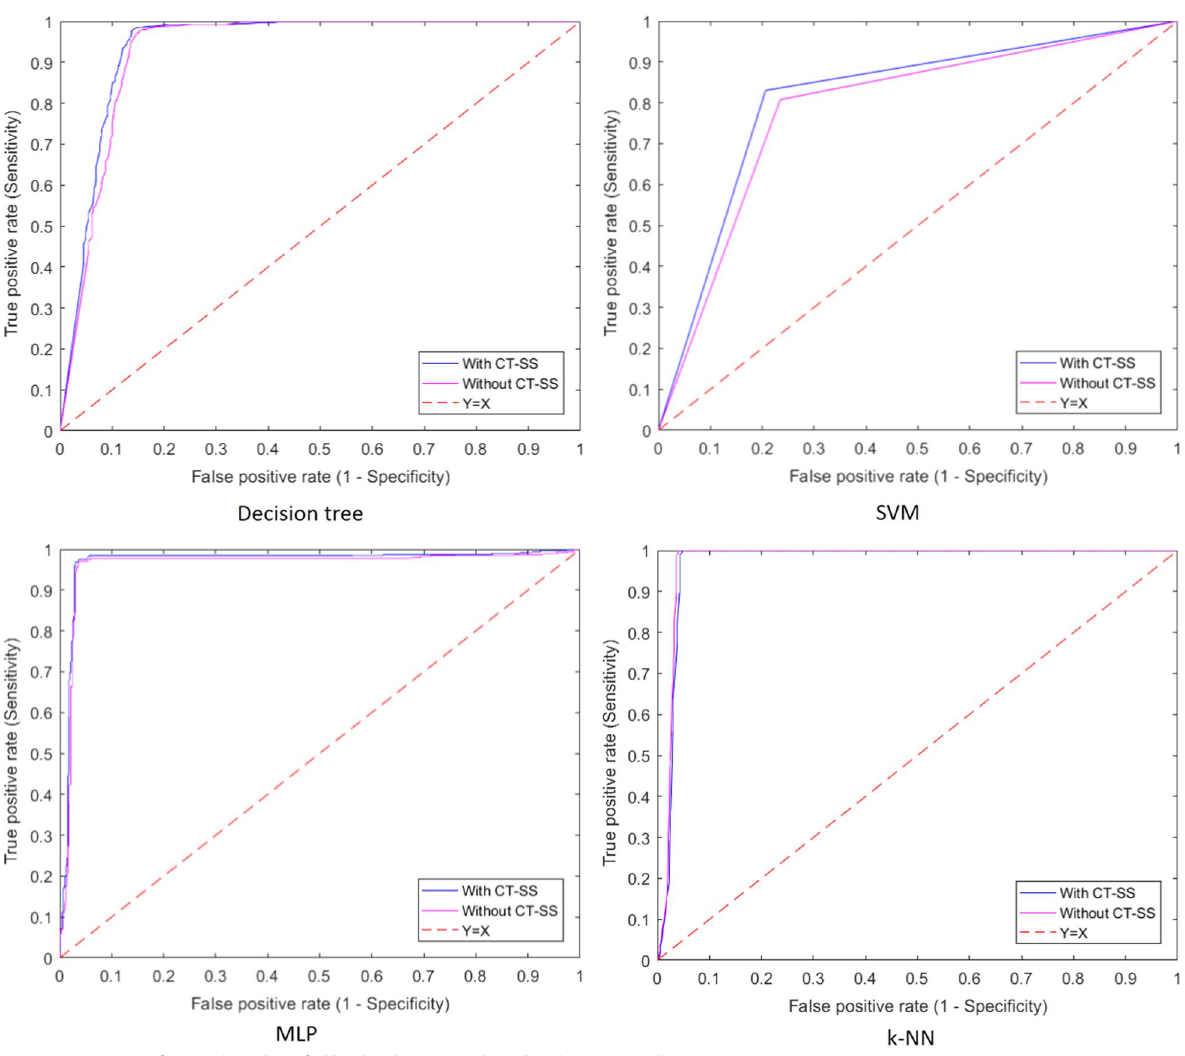
Fig. 2 ROC curves for ML algorithms fed by the datasets with and without CT-SS